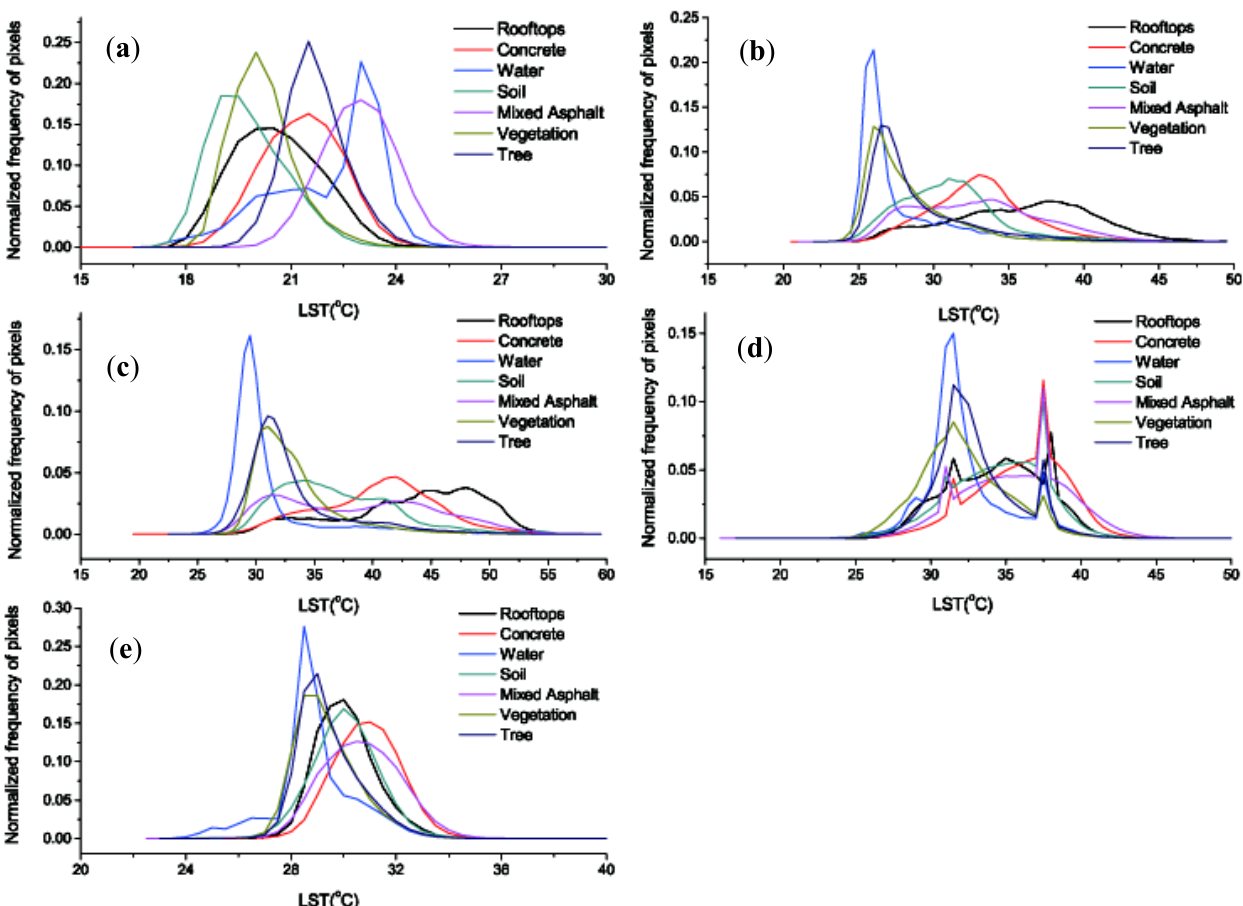
Figure 11. Histogram of LST over all land covers on ( a ) the morning of 7 August 2010; ( b ) the noon of 7 August 2010; ( c ) the noon of 15 August 2010; ( d ) the evening of 25 July 2010; ( e ) the evening of 27 July